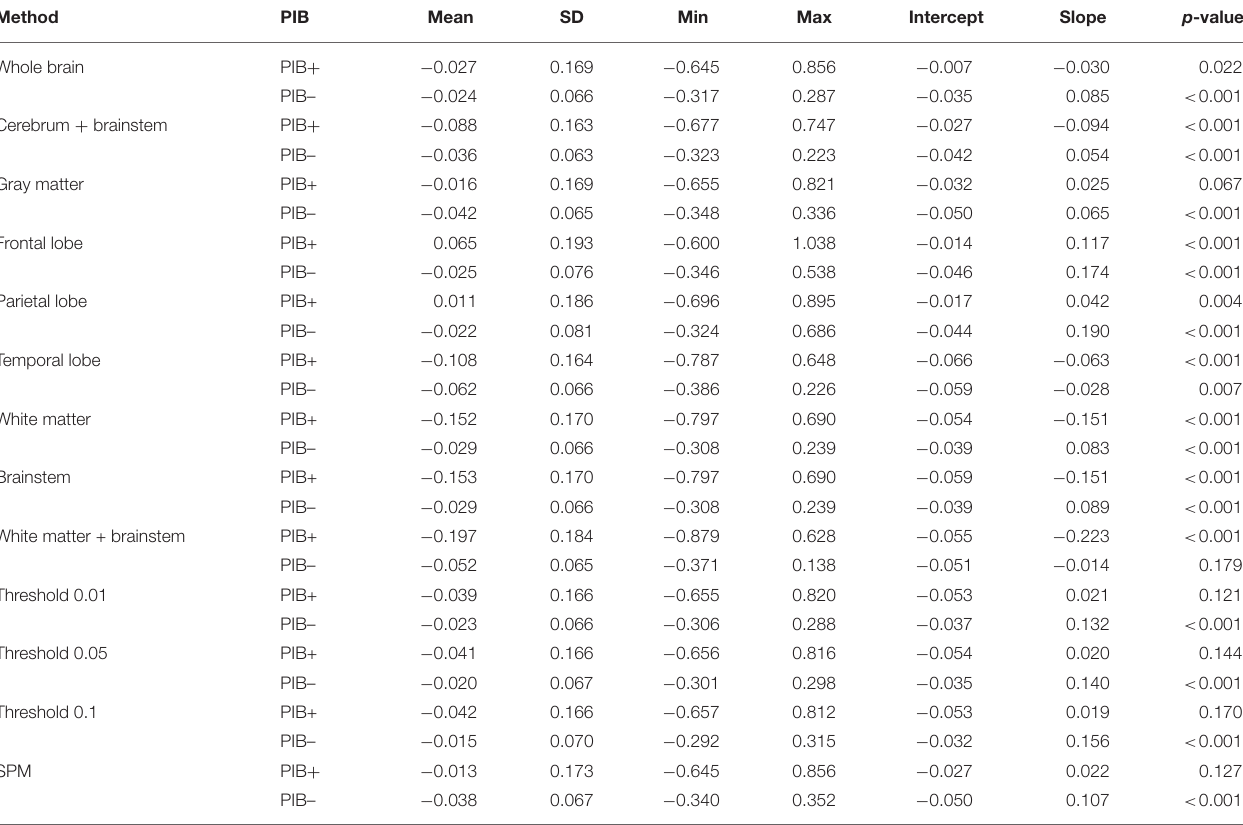
TABLE 2 | Results from the bias assessment comparing BP SRTM ND and BP SRTM 2 ND from different